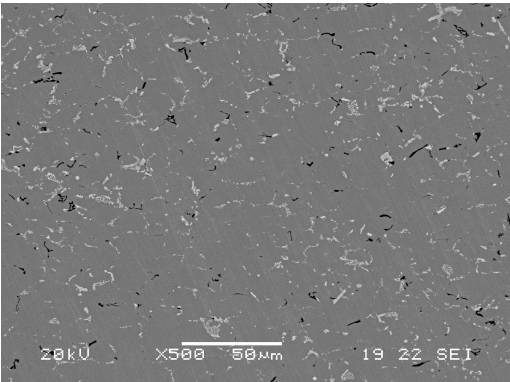
Figure 6. Characteristic microstructure after hot rolling of the material with a 90% reduction in cross ‐ section, obtained by scanning electron microscopy. Grain refinement by hot dynamic restoration and hot static recrystallization.